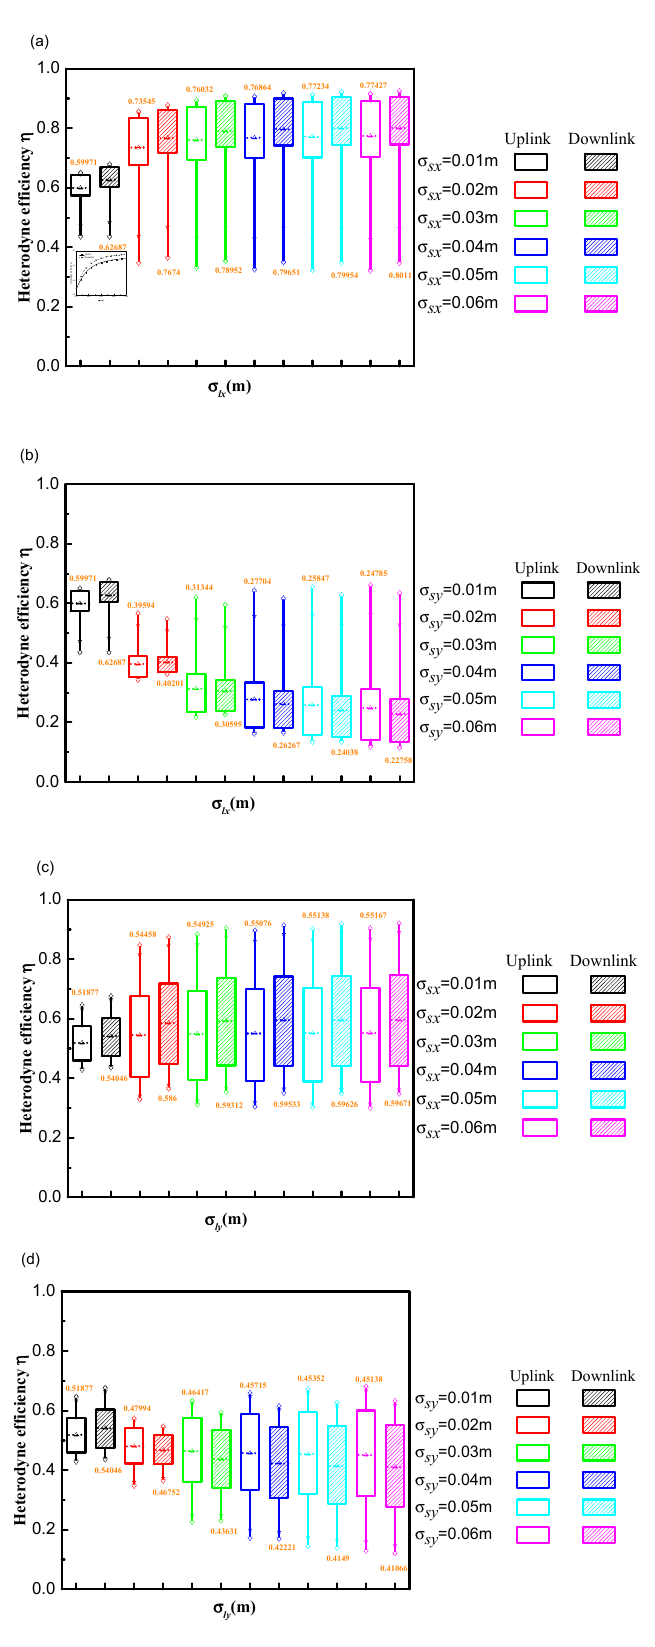
Figure 3. Effect of waist radius of LO beam on the heterodyne efficiency on an uplink path and a downlink path ( a ) σ lx and σ sx , ( b ) σ lx and σ sy , ( c ) σ ly and σ sx , ( d ) σ ly and σ sy .